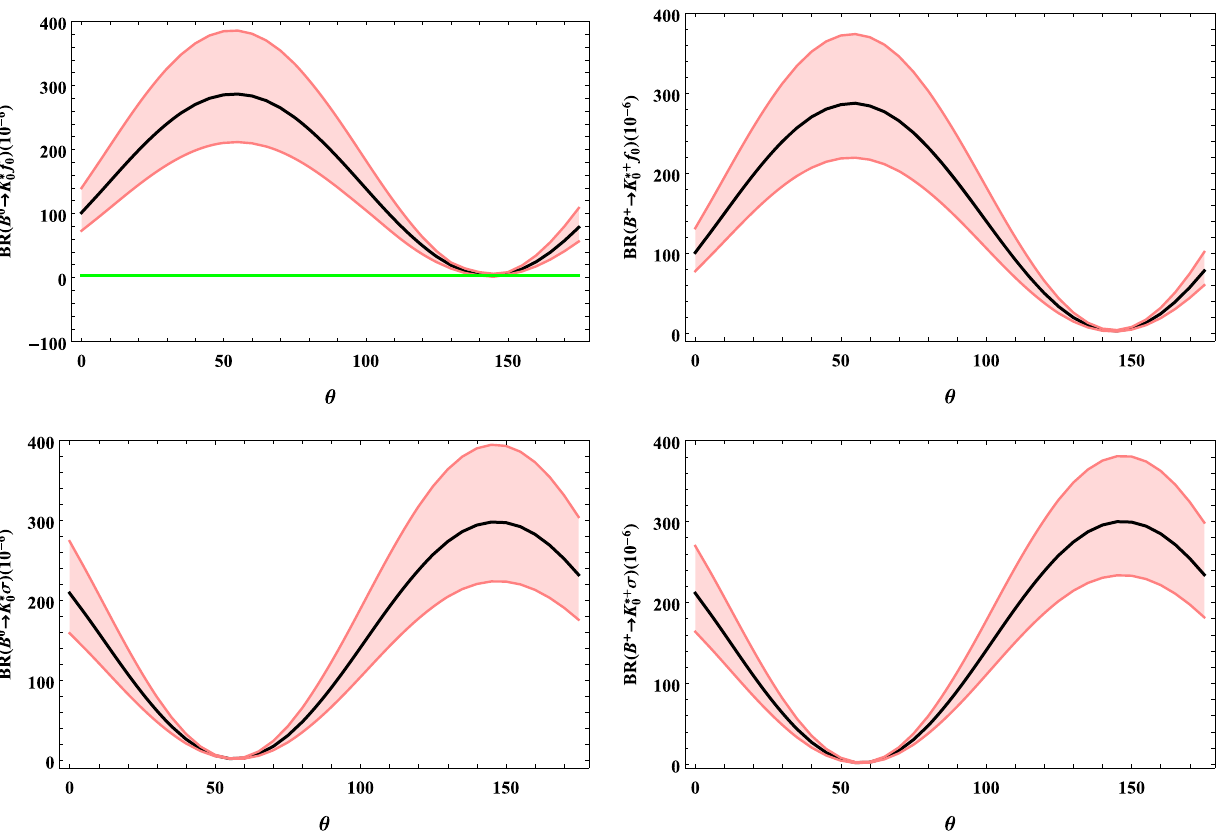
σ with variant of the mixing angle θ . The black lines are the center values, and the f 0 and B → K ∗ 0 2